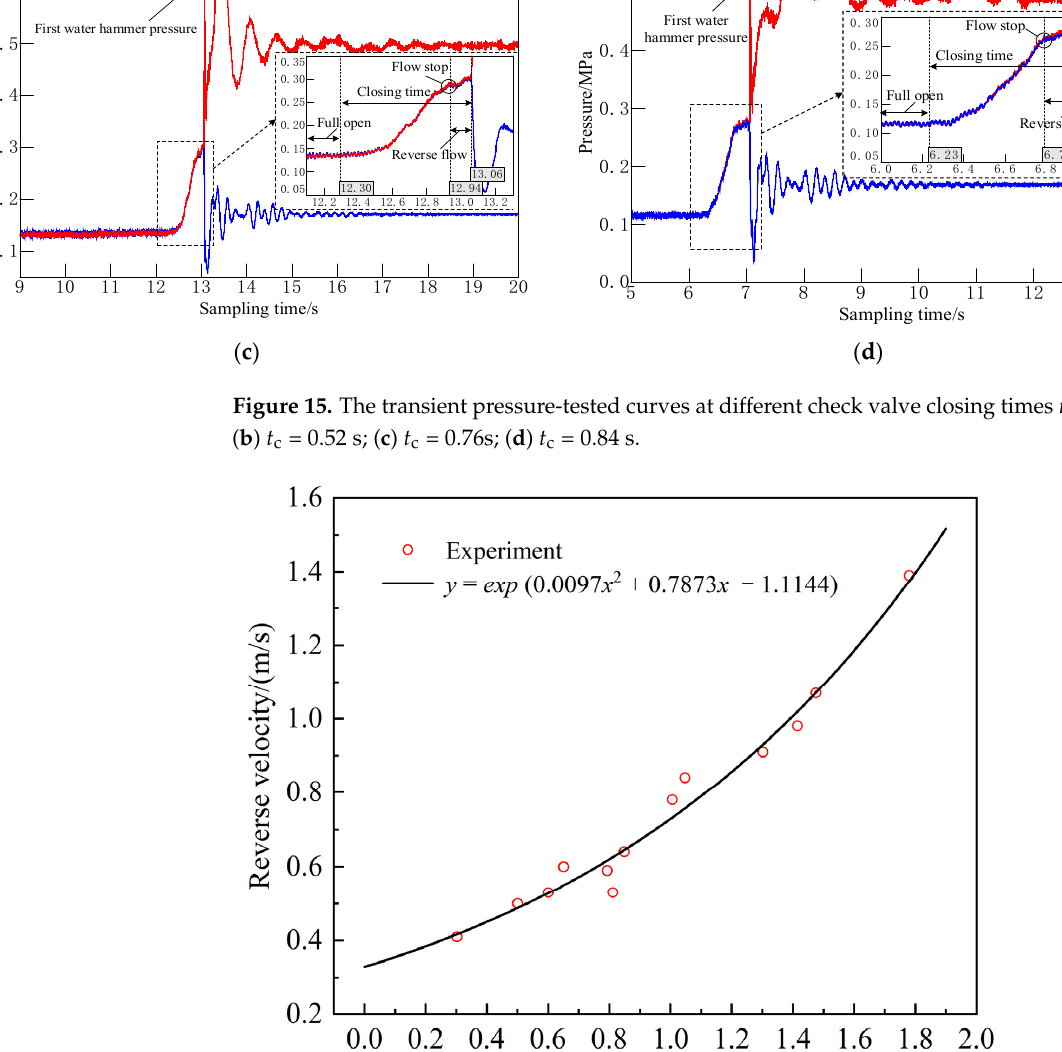
Figure 16. The dynamic characteristic curve of the dual disc check valve. It is necessary to analyze the dimensionless variables to study the dynamic charac- teristics of dual disc check valves with similar structures. Using the ratio of v R and v 0 ob- tains the dimensionless maximum reverse flow velocity v * (see Formula (18)). In the same way, using the rate of d v /d t and v 02 / d achieves the dimensionless fluid deceleration A * (see Formula (19)). Finally, the A *- v * curve is the dimensionless dynamic characteristic curve of the check valve [2].